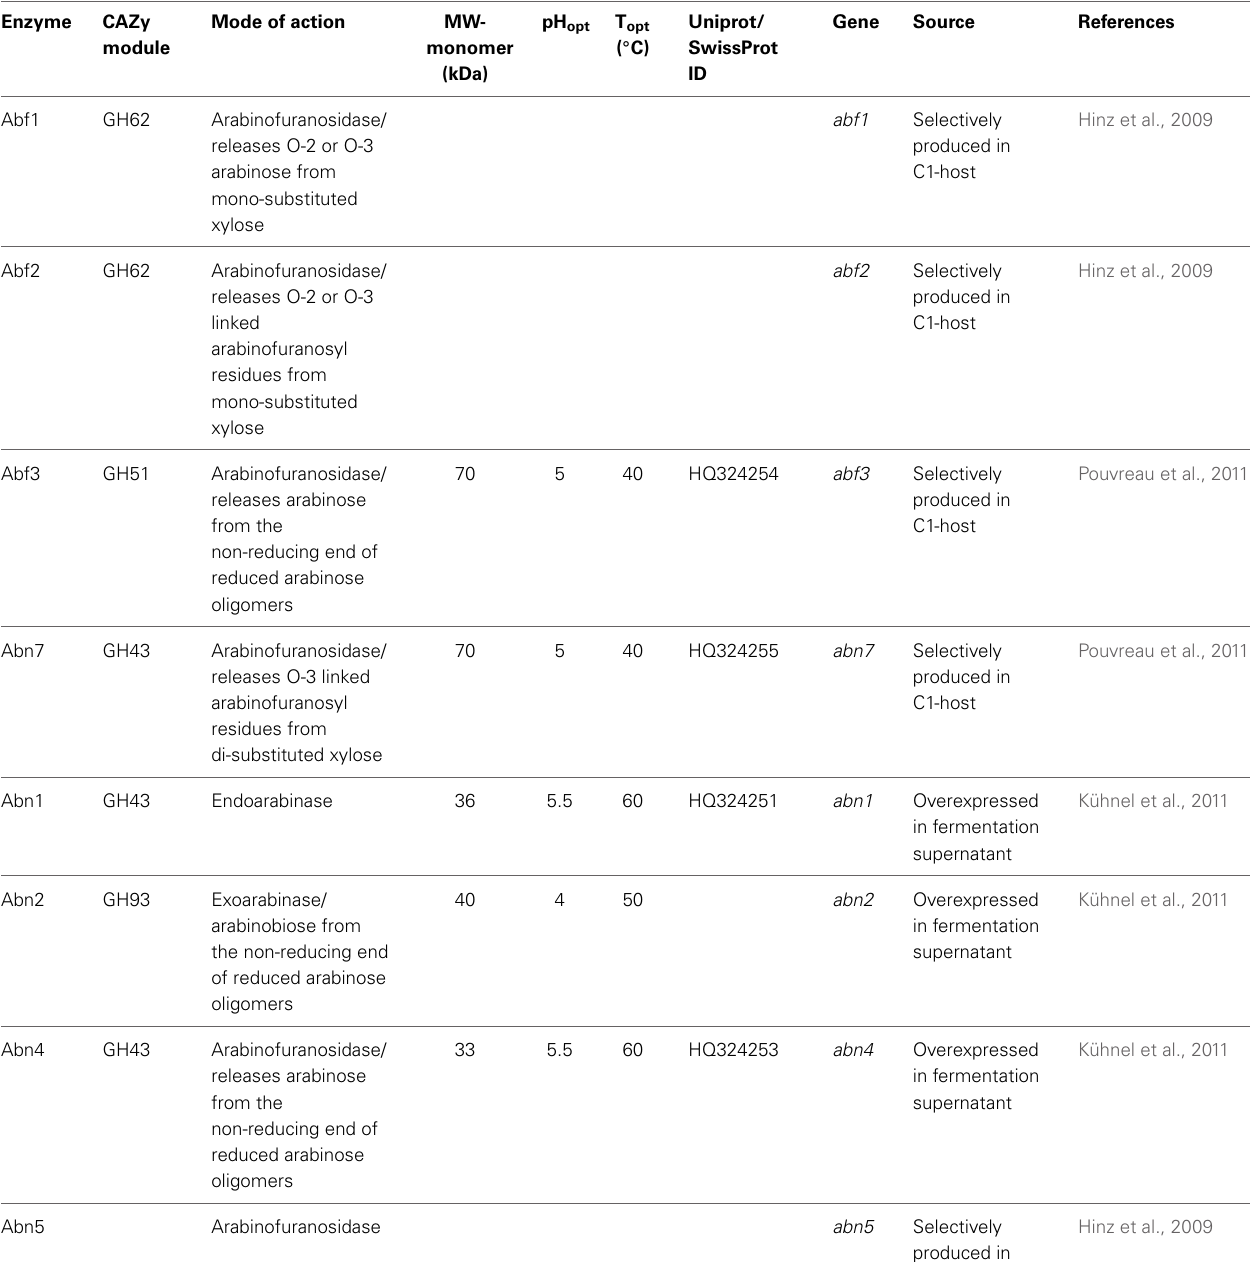
Table 7 | Description of the characterized endoarabinases and arabinofuranosidases isolated from the culture broth of a M. thermophila C1 mutant